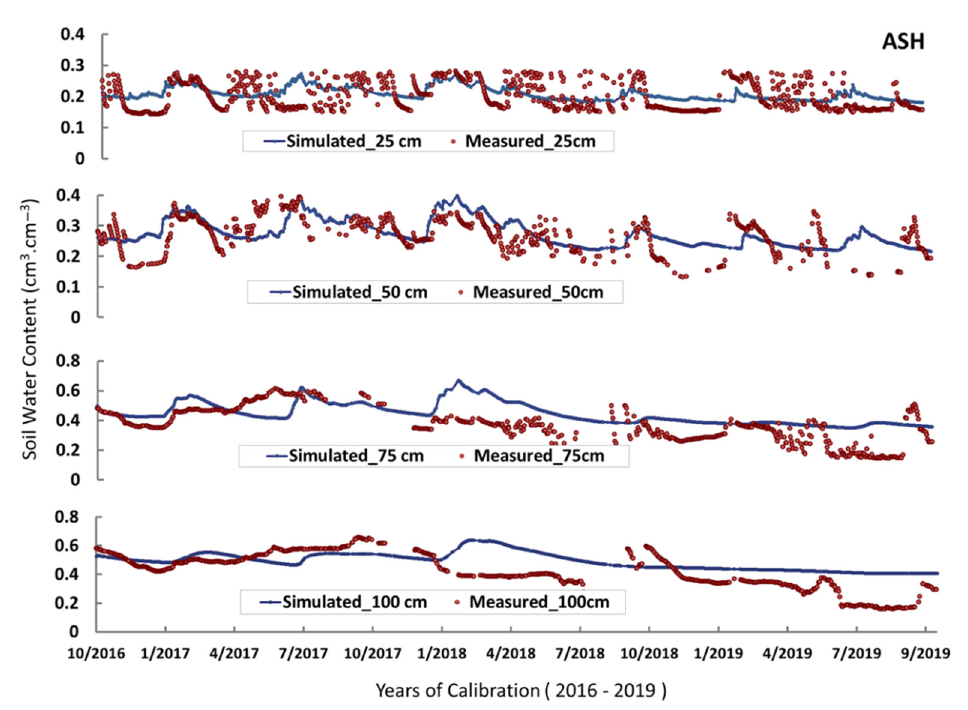
Figure 4. Measured (dots) and simulated (lines) soil water contents at four root zone depths of 25, 50, 75, and 100 cm at the ASH site.